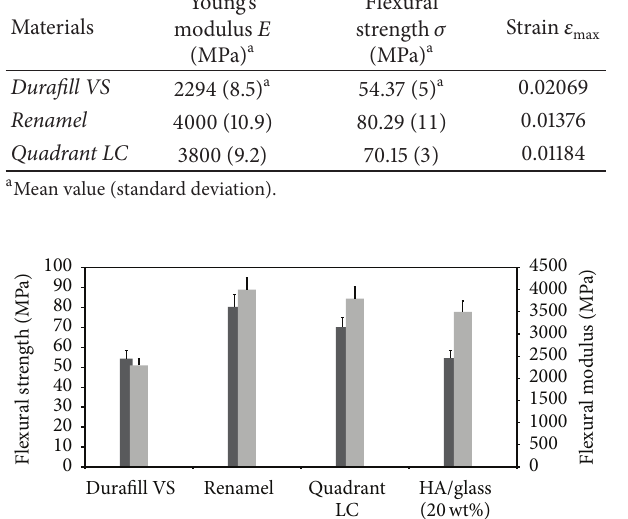
Figure 9: Flexural strength (dark grey) and elastic modulus (light grey) of four-resin based